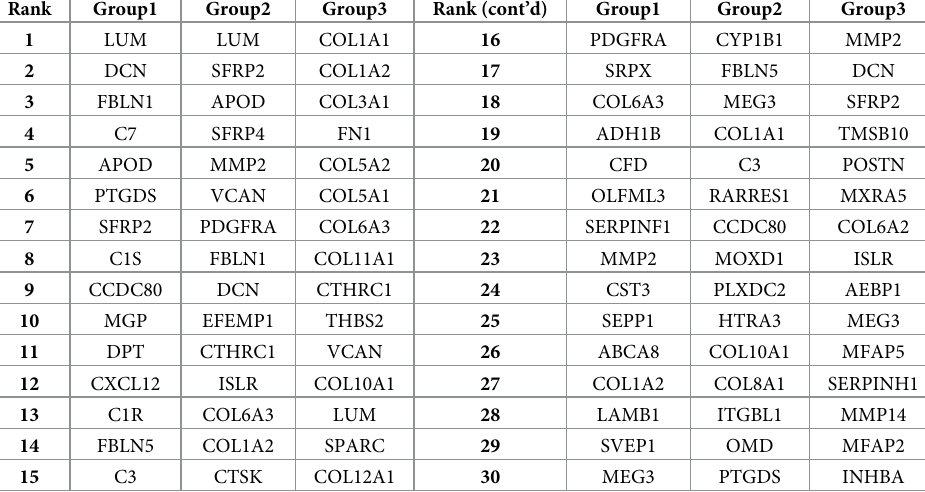
Table 6. Top 30 genes of the consensus attractors for three different PDAC sample groups. Group1: normal sam- ples; Group 3: T11, T21, T23, T9, T16, T17, T8; Group 2: other tumor